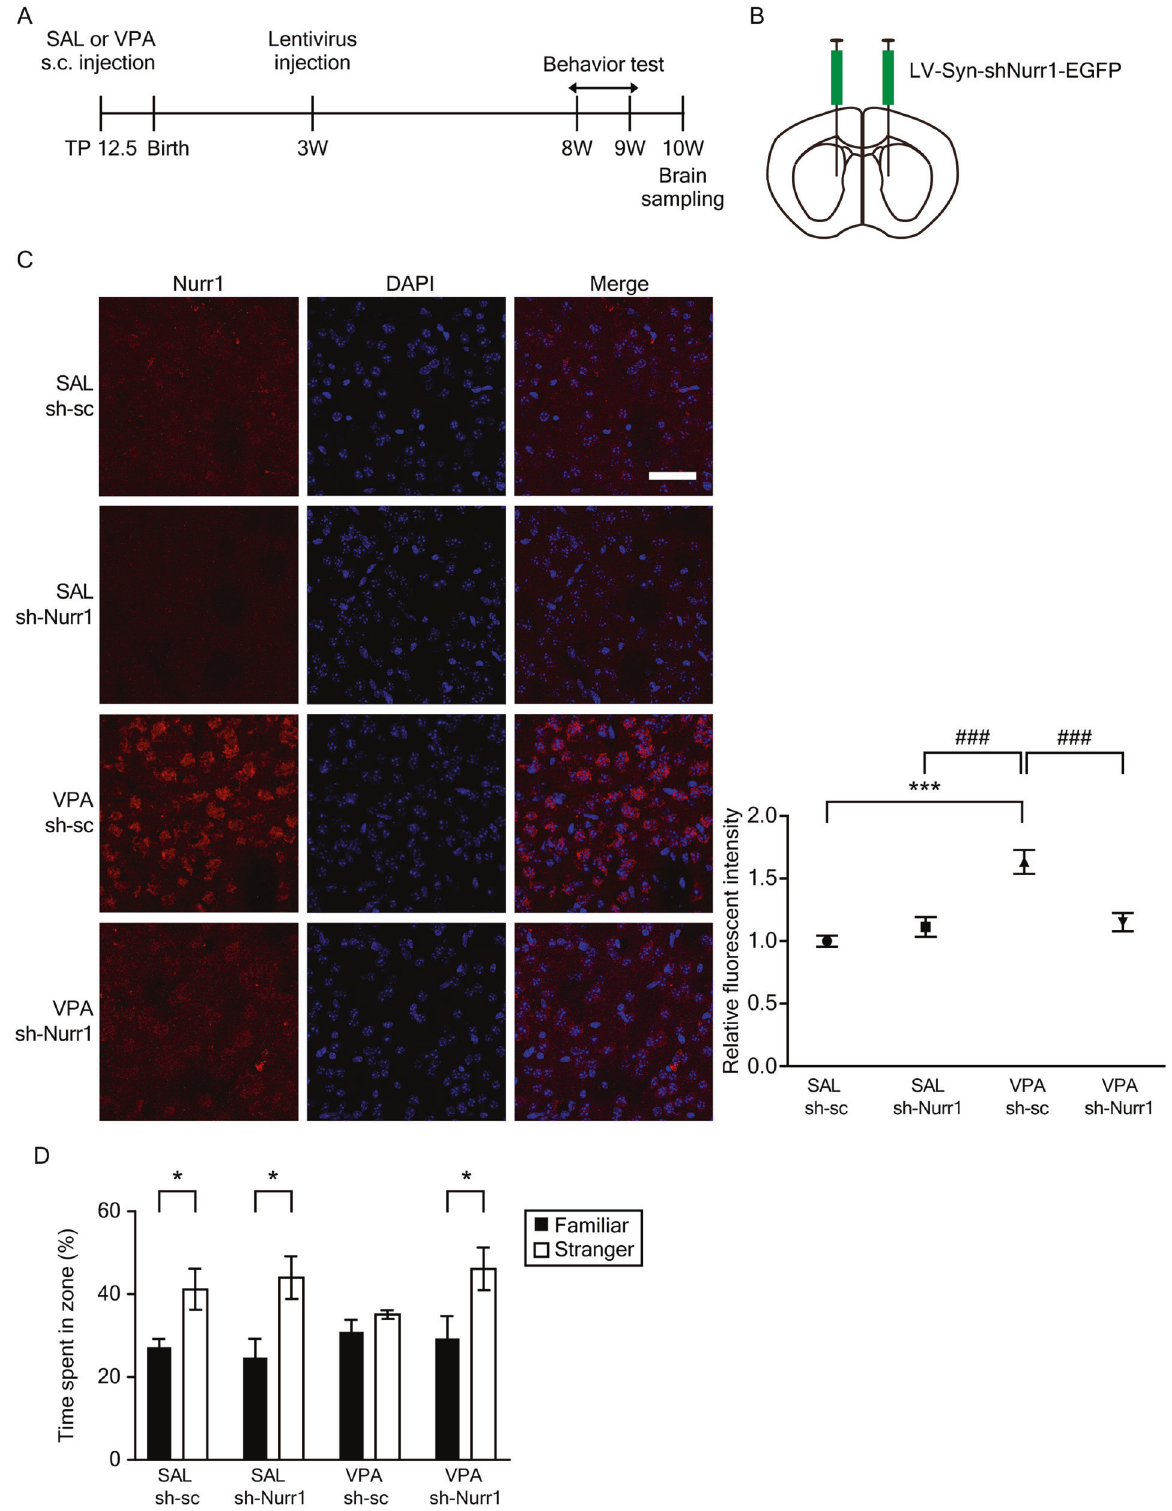
Fig. 3 Lentiviral Nurr1 knockdown in the striatum rescued autism-like social de fi cits in prenatally VPA-exposed 10-week-old mice. A , B Schematic illustrations displaying the experimental paradigms of behavior tests ( A ) and lentiviral injection ( B ). C Representative fi gures of immunohistochemical experiments and the quanti fi cation of Nurr1 + immuno fl uorescence intensity (SAL Veh, n = 5; SAL sh-Nurr1, n = 7; VPA Veh, n = 5; VPA sh-Nurr1, n = 7). *** p < 0.001 compared to SAL sh-sc mice, ### p < 0.001 compared to VPA sh-sc mice, one-way ANOVA. D The interaction time with familiar and novel mice ( F (3, 60) = 1.329, p = 0.277, interaction; F (3, 60) = 0.056, p = 0.946, group; F (1, 60) = 11.509, p = 0.002, familiar vs. novel, two-way ANOVA, SAL sh-sc, n = 8; SAL sh-Nurr1, n = 8; VPA sh-sc, n = 9; VPA sh-Nurr1, n = 9). * p < 0.05 compared to time in zone with familiar mouse, unpaired t